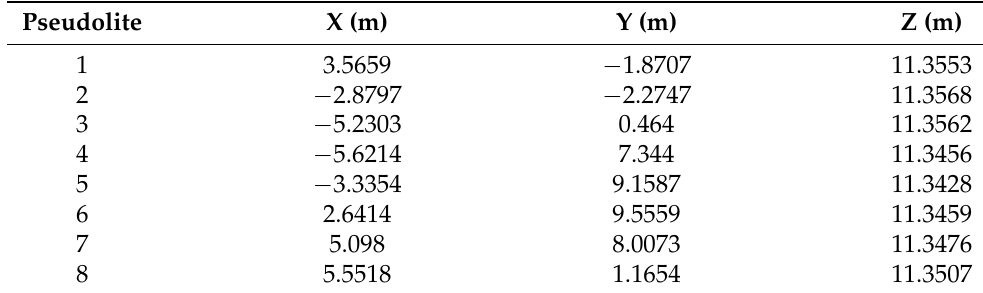
Table 4. Position distribution of